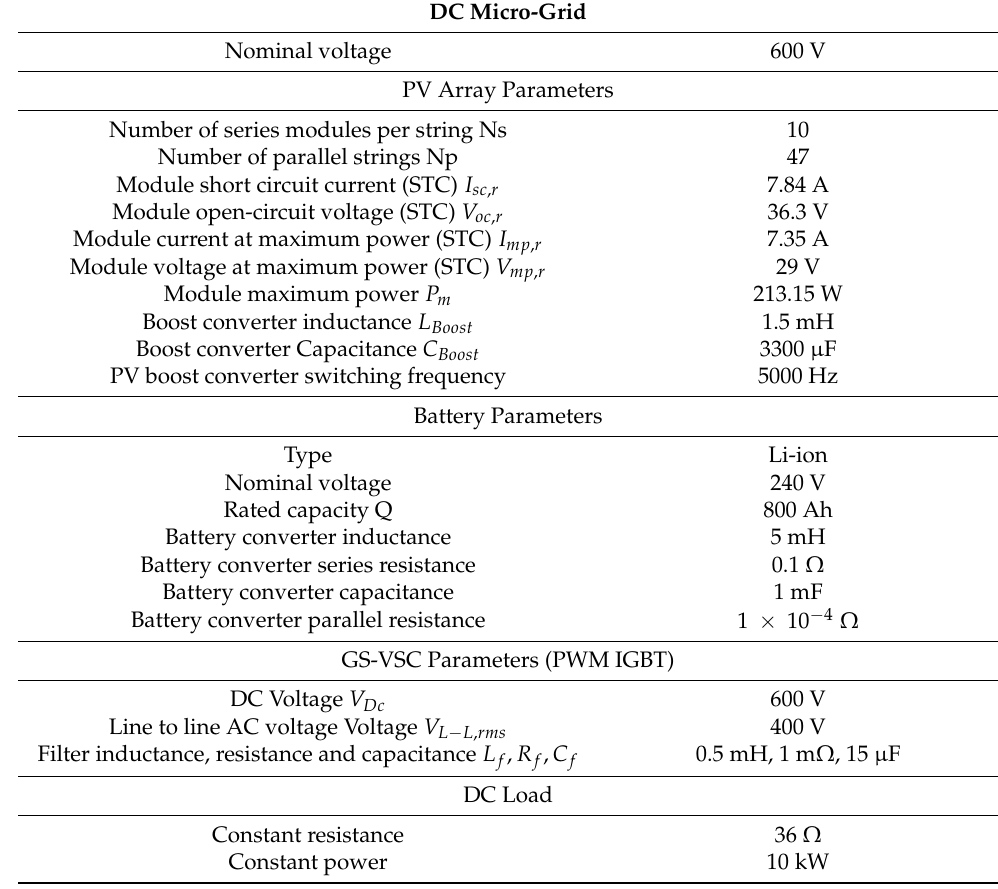
Table 2. Parameters of DC microgrid PV Array, battery, and DC